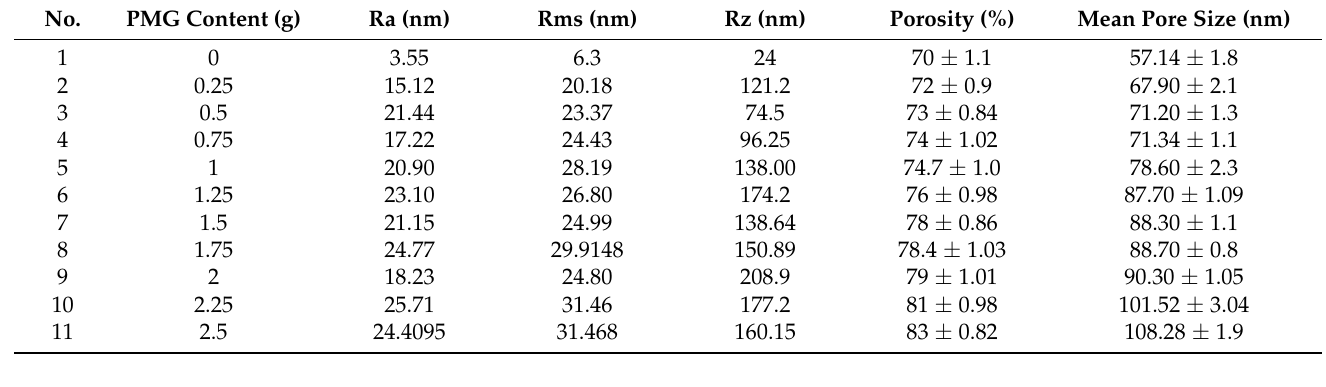
Table 3. Roughness parameters of the control and PMG-modified membranes.